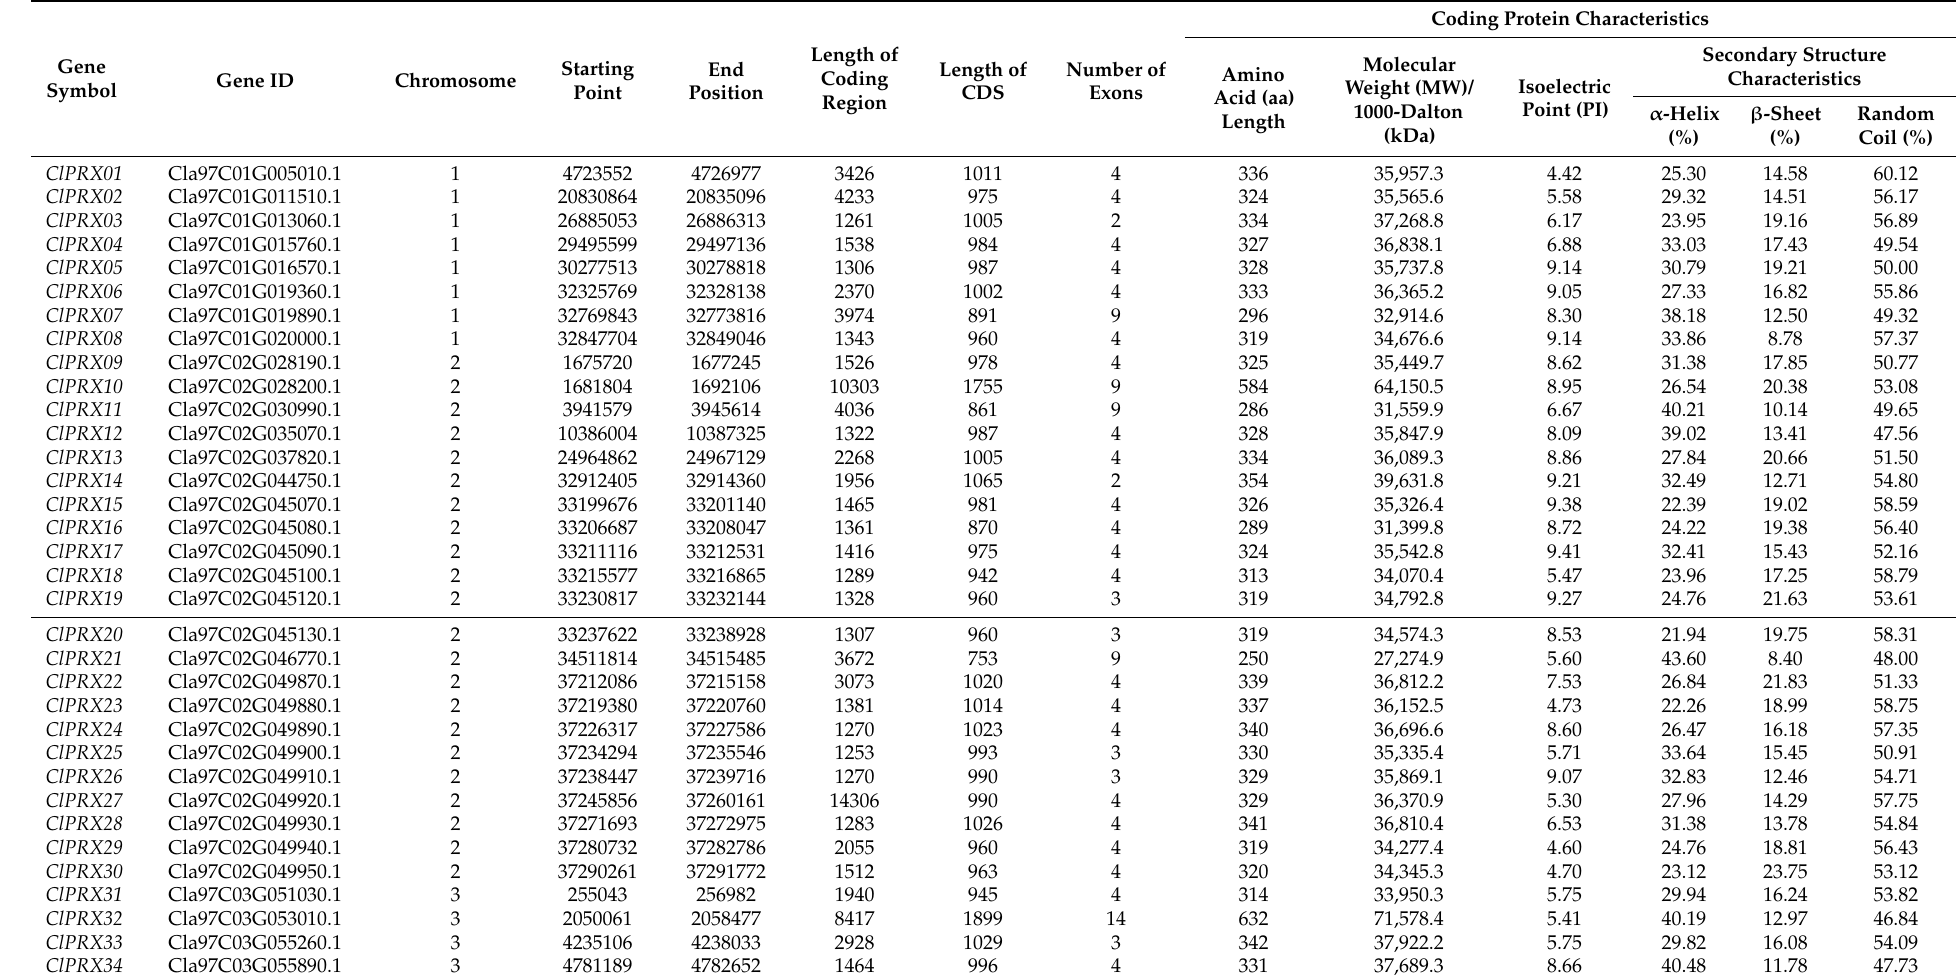
Table 1. The detailed genes information of